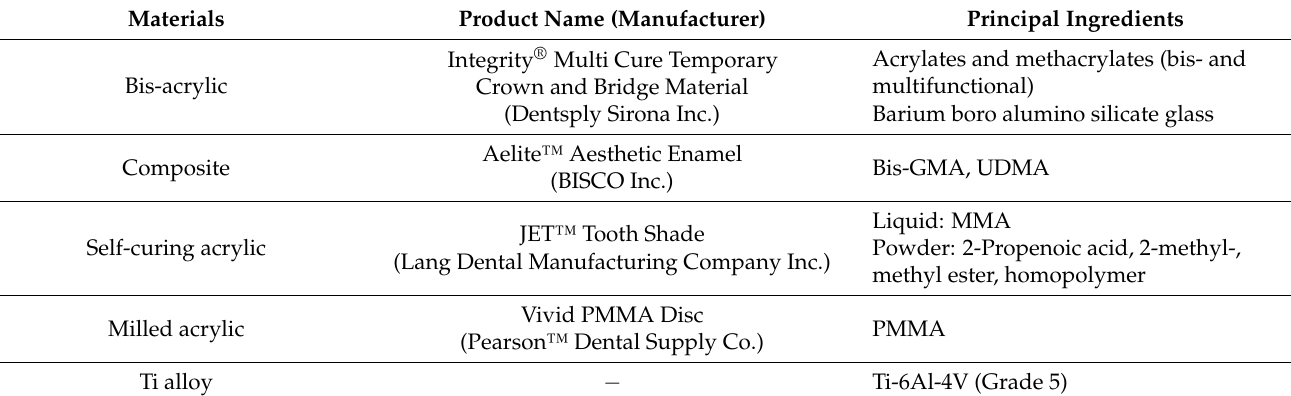
Figure 1. Test materials and the experimental design for counting cells. ( A ) Prepared rectangular samples (6 mm × 14 mm, 2 mm thick). a, bis-acrylic; b, composite; c, self-curing acrylic; d, milled acrylic; and e, Ti alloy. ( B ) Attached cells were counted to determine contact and proximity effects, where the contact effect was the quantification of cells attached to test materials and the proximity effect was the quantification of cells attached to the well of the culture dish (20 mm diameter) around the materials. Table 1. Materials used in this study.